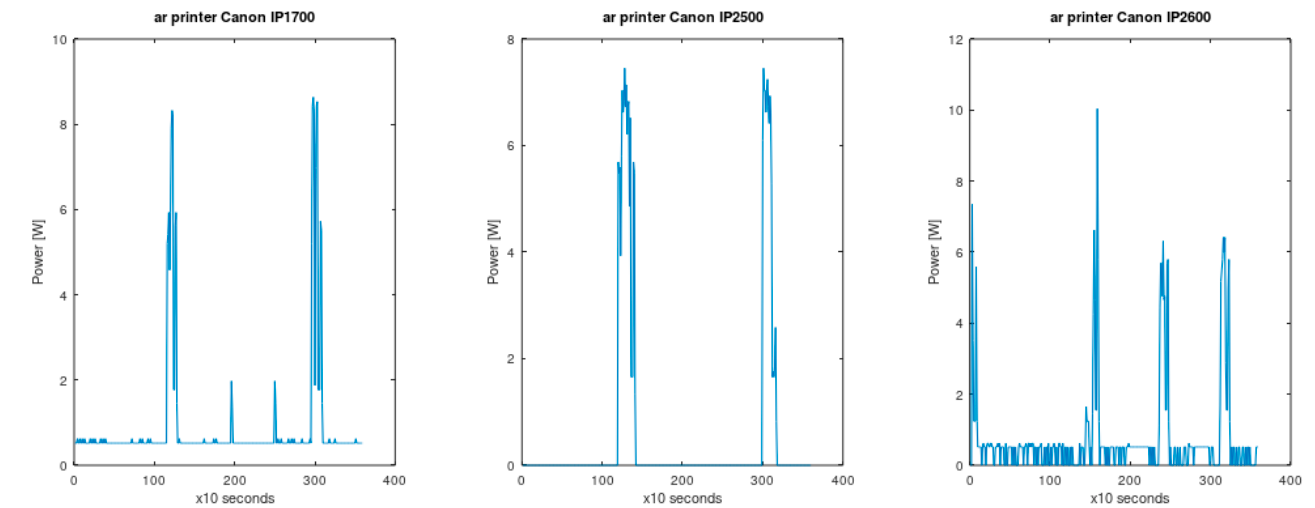
Figure 10. The trend of power absorbed during typical use of printers.